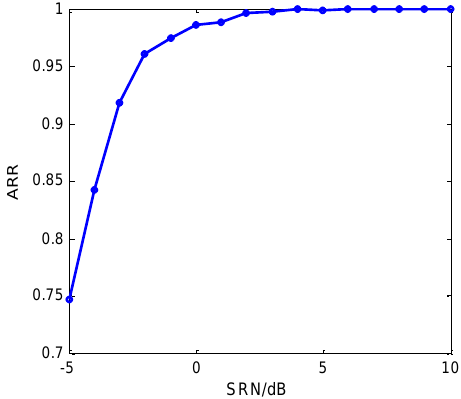
Figure 16. ARR of the proposed method with different slopes on LFM.